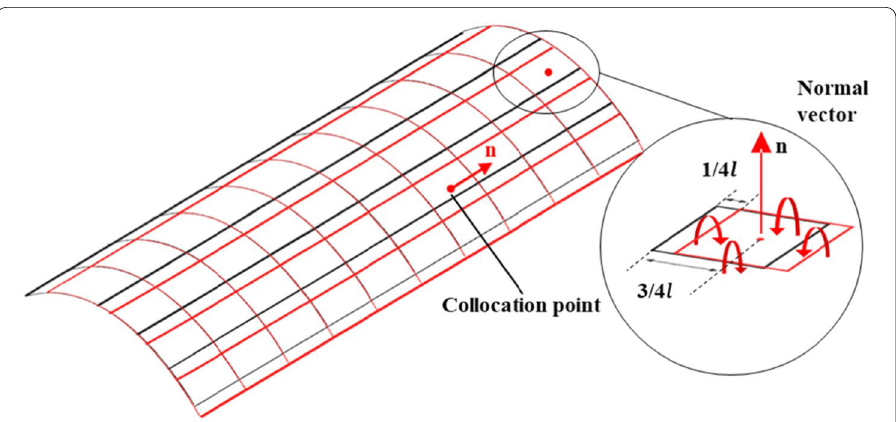
Fig. 1 Discretization of lifting surface by vortex